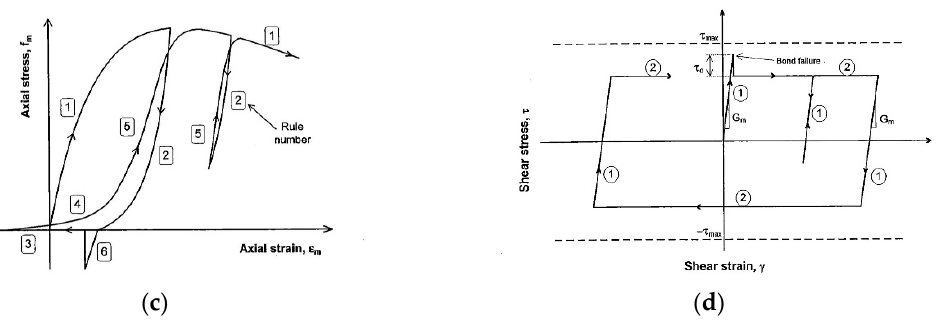
Figure 1. Equivalent diagonal strut model and fiber elements: ( a ) compression or tension struts and shear strut [39]; ( b ) fiber elements associated with RC cross-section [39]; ( c ) strut curve parameters [38]; and ( d ) shear curve parameters [38].